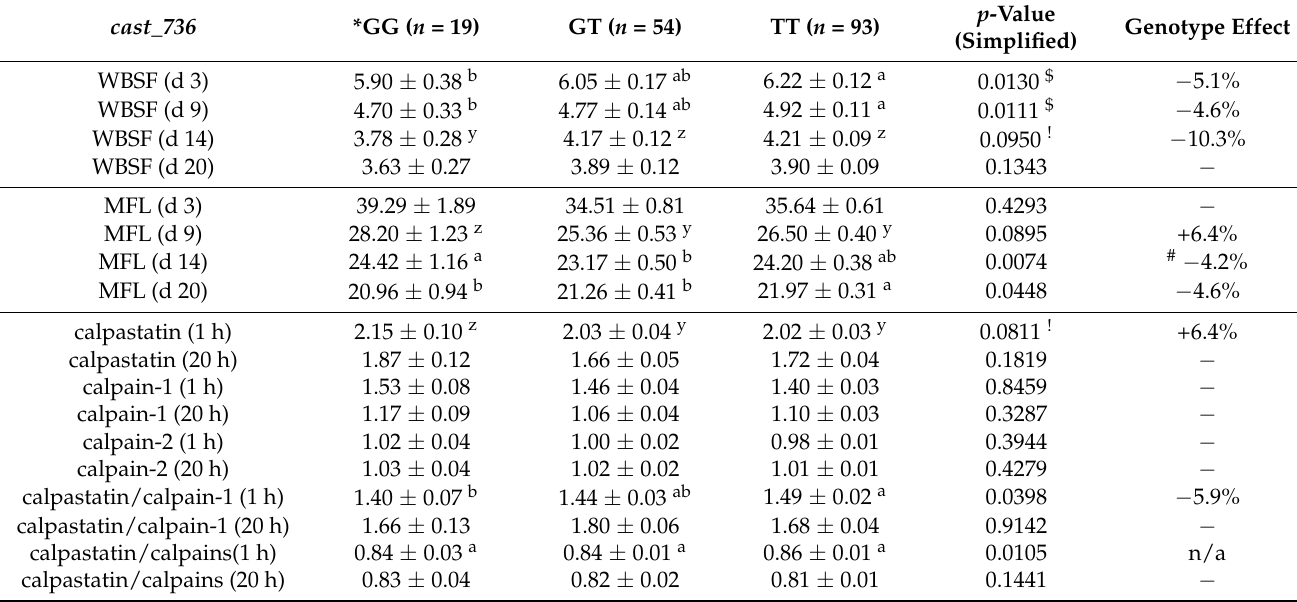
Table 2. The effects of genotype of the cast_736 SNP on the tenderness phenotypes, Warner–Bratzler shear force (WBSF) and myofibril fragment length (MFL) of representative purebred South African beef bulls during three to 20 days of ageing and on the muscle protease enzyme system during the first 20 h